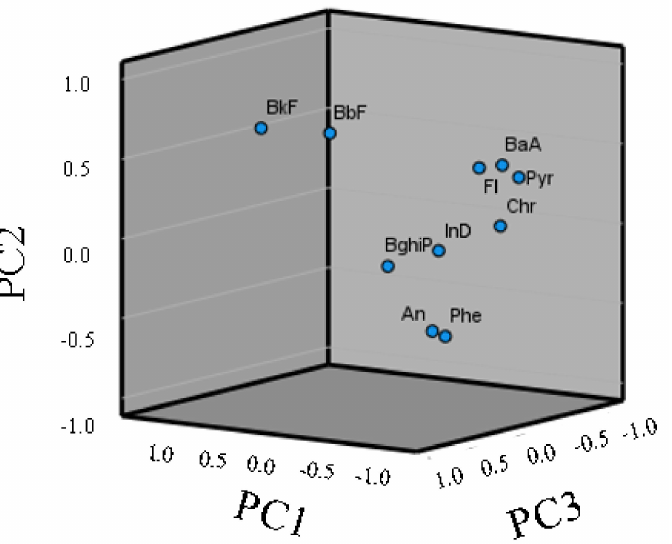
Figure 5. Principal component analysis (PCA) of PAH composition in samples from the Sele River estuary, southern